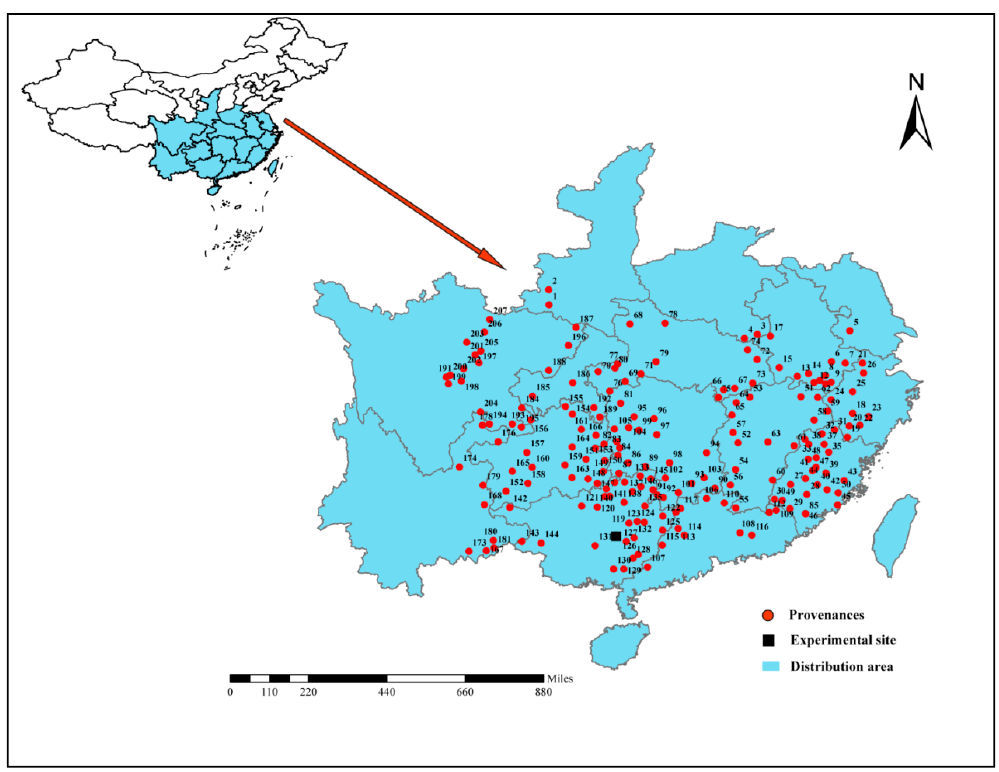
Figure 2. Sample information of the 195 Chinese fir ( Cunninghamialanceolata ) provenances used in this study. Experimental site (square), provenances (dots). The range of the natural distribution of Chinese fir is shown in blue.